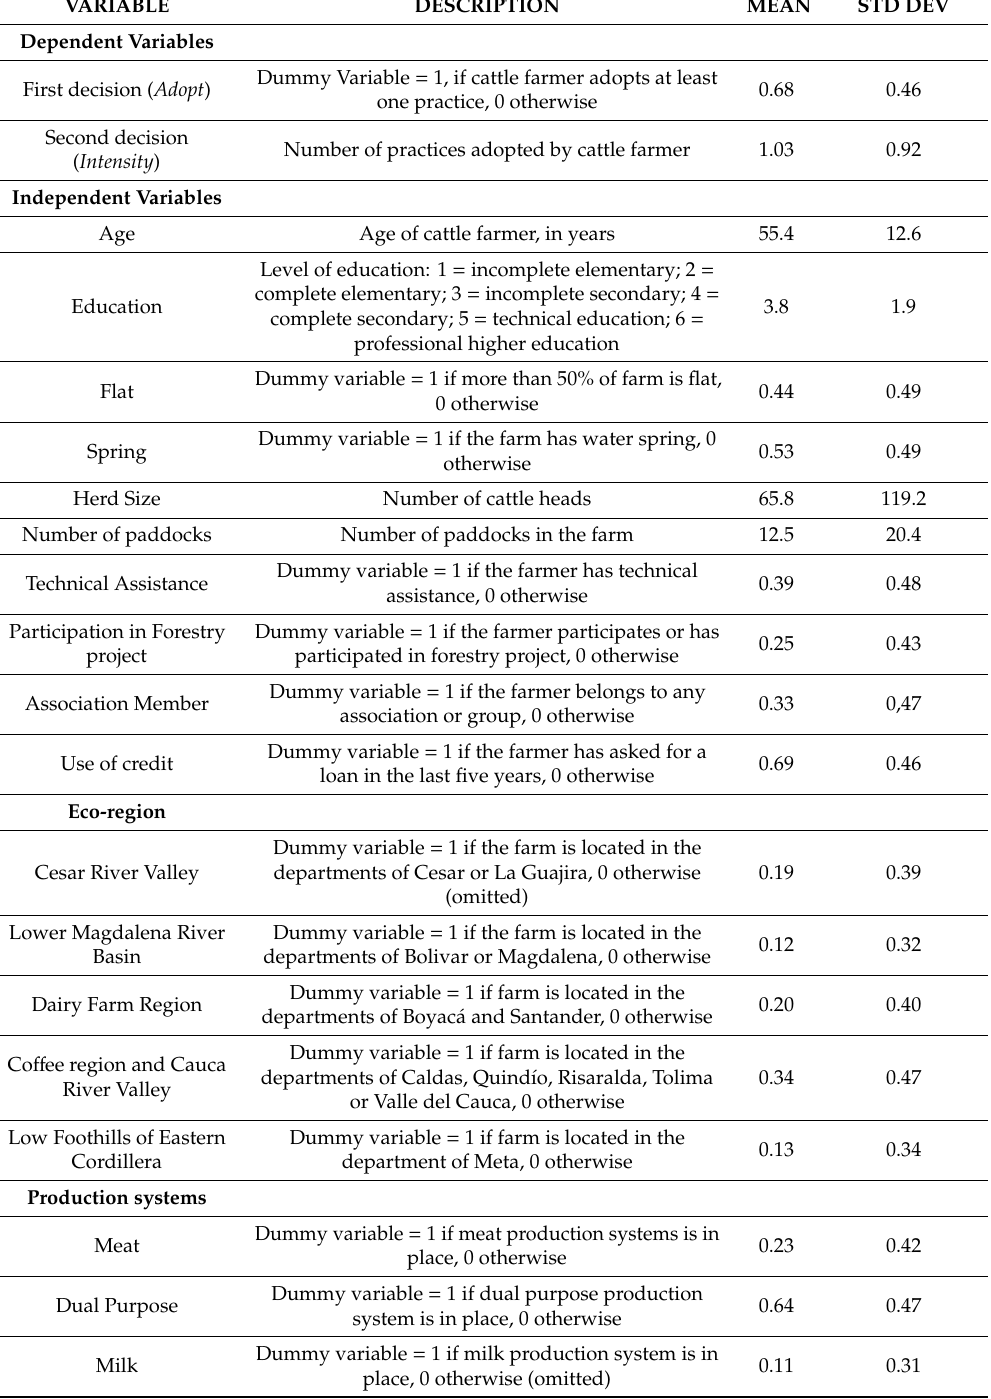
Table 2. Description and summary statistics of variables used in the